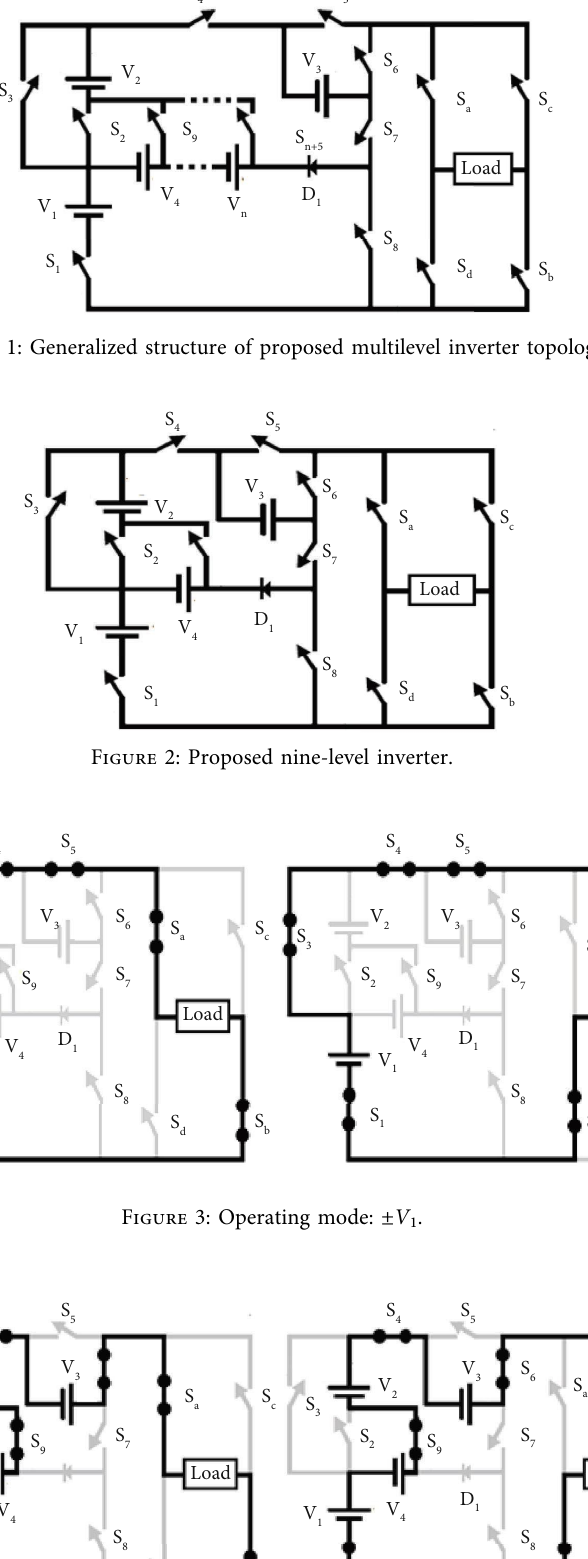
Figure 4: Operating mode: ± ( V